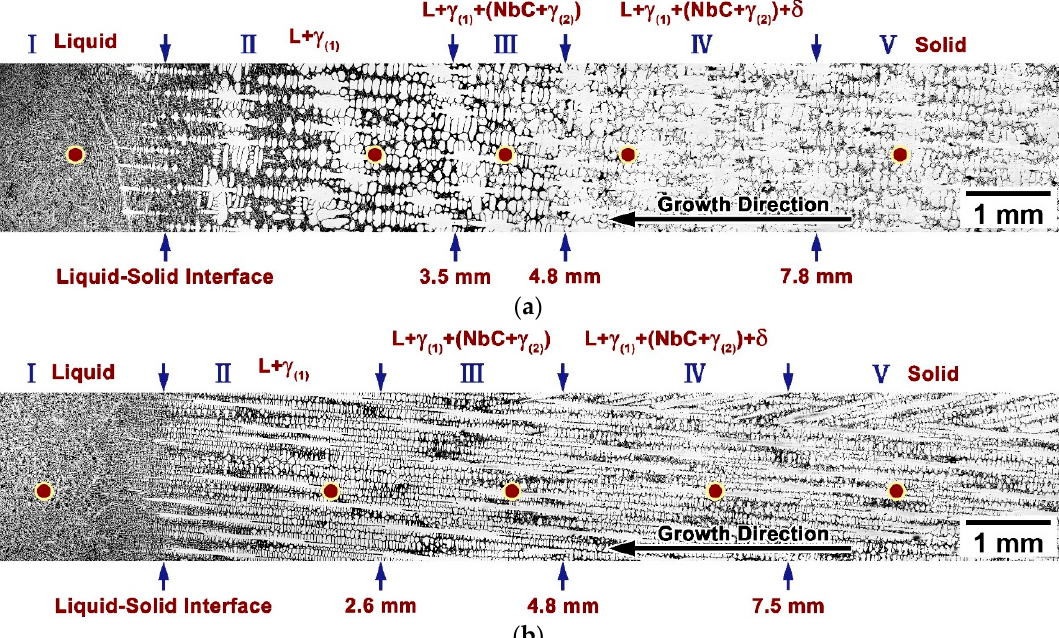
Figure 6. Optical images of longitudinal microstructures of the mushy zones in as-cast alloy 3C2N after the LMC-DS processing under different withdraw rates: ( a ) 20 and ( b ) 50 µ m/s. Volume fractions of solid phase in the two mushy zones are plotted in Figure 7 as a function of distance from the L/S interface. When the temperature decreased below the liquidus temperature, solidification started with a sharp increase in the volume fraction of solid phase. Two obvious peaks were observed on the volume fraction cure withdrawn at 20 (cid:912) m/s, corresponding well to the coarse, nodular dendrites in stage II, as shown in Figure 6a. The volume fraction increased continuously and